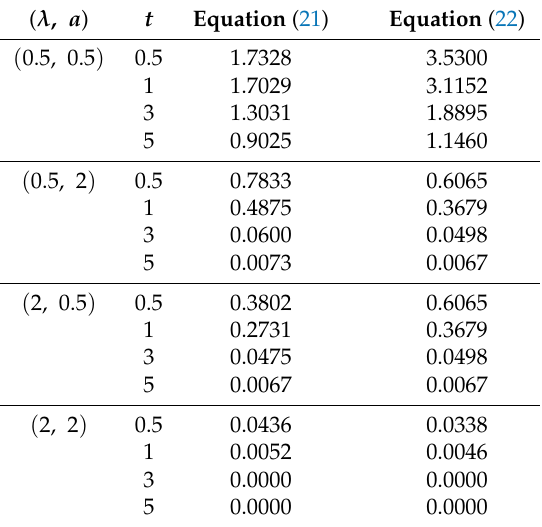
Table 1. MRL for some parameter